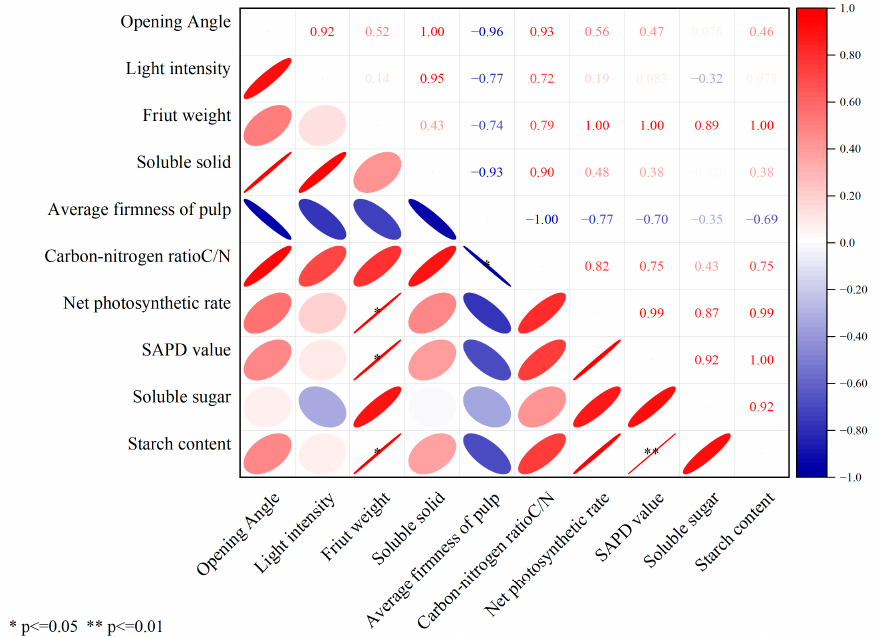
Figure 10. Correlation analysis between relative light intensity and leaf and fruit